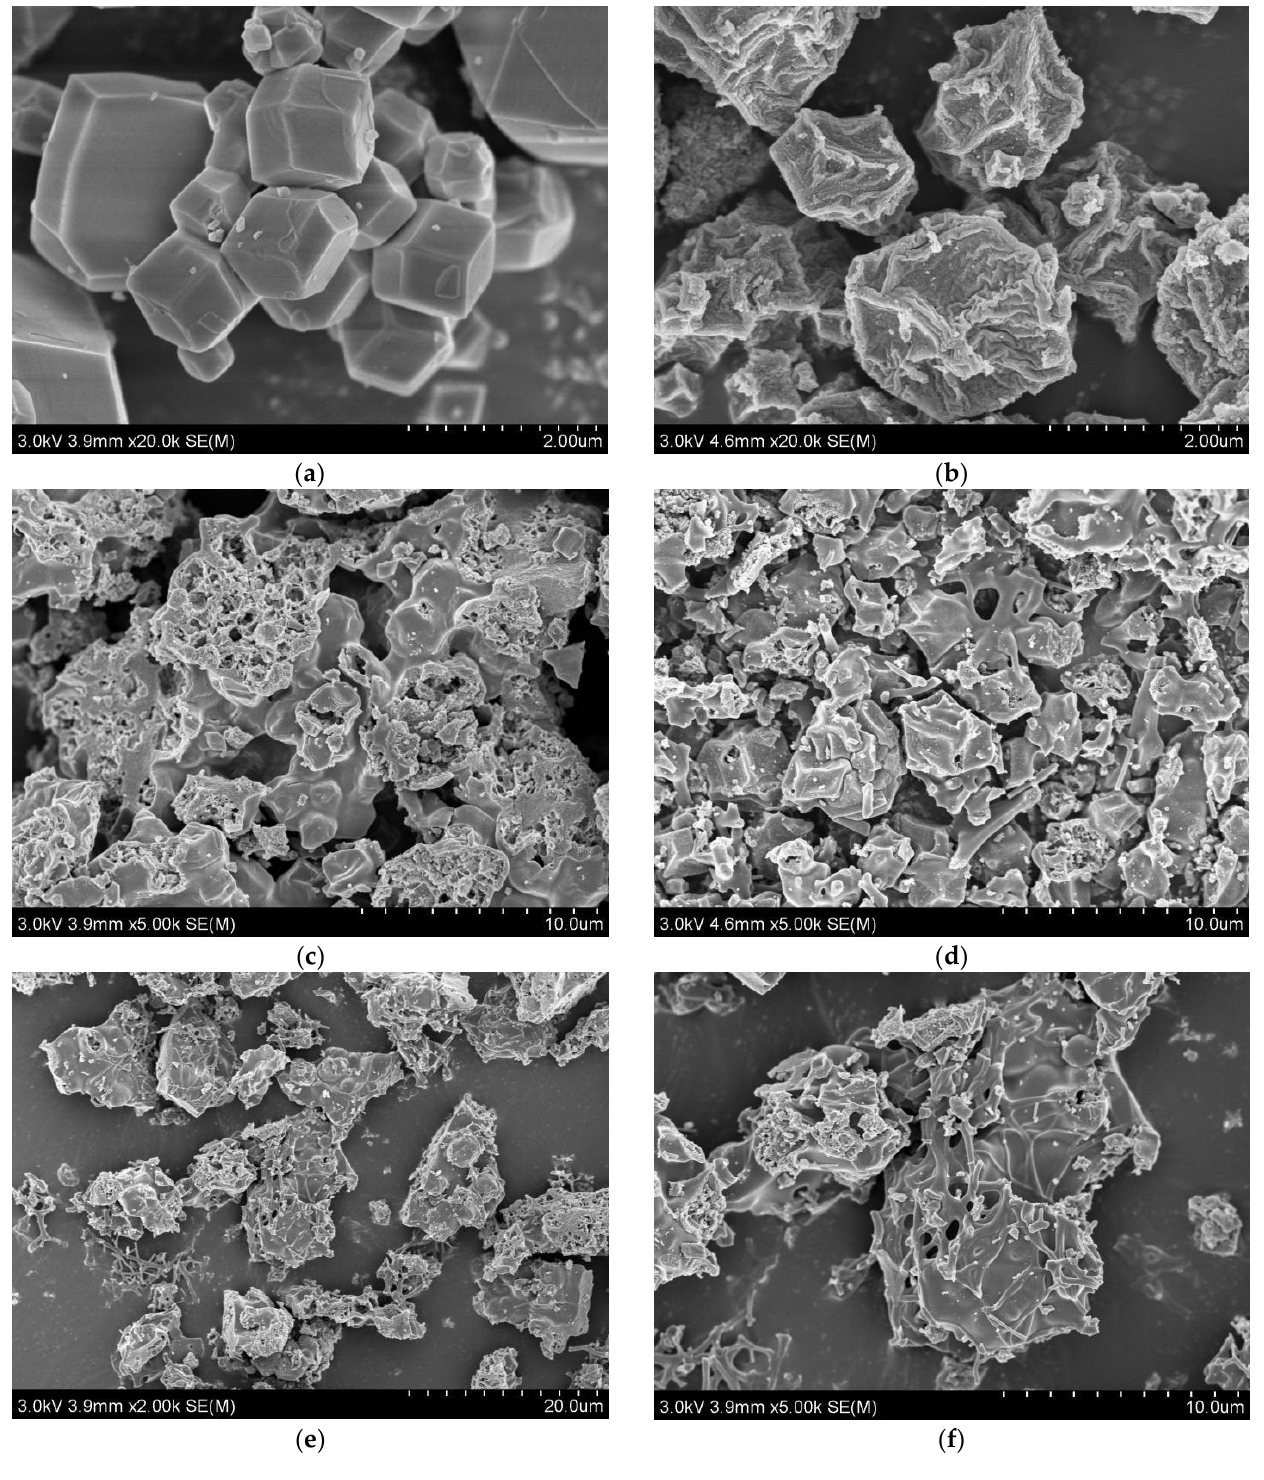
Figure 1. SEM images of ( a ) ZIF-67, ( b ) Z600, ( c ) ZP400, ( d ) ZP800 and ( e , f ) ZP600. FTIR was applied to analyze the surface functional groups of the synthesized prod- ucts. The pattern of ZIF-67 was consistent with the previous report [28]. The peaks of 600 – 1500 cm −1 in the spectrum (Figure 2) of ZIF-67 were caused by the stretching and bending modes of the imidazole ring. The peak at 1448 cm −1 was generated from the stretching of C=N bond in 2-MeIM. The peaks at 2929 and 3135 cm – 1 were attributed to C-H bonds [29]. Moreover, it was noticed that ZP400 showed a similar pattern to ZIF-67, and there was no obvious characteristic peak of 2-MeIM in the patterns of ZP600 and ZP800. This result indicated that the structure of ZIF-67 may not have been completely destroyed when the